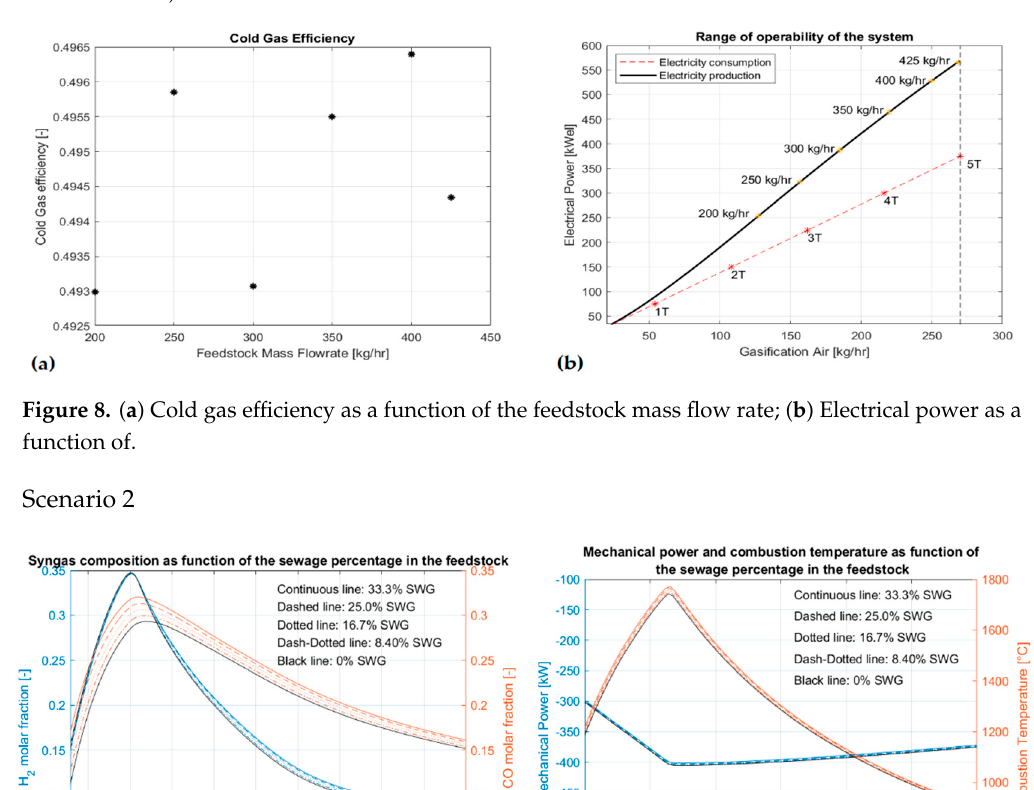
Figure 10. ( a ) Syngas and feedstock lower heating value (LHV) as a function of sewage fraction; ( b ) cold gas efficiency as a function of the sewage fraction. Figure 11. ( a ) Sorbent consumption as a function of sewage fraction; ( b ) mechanical power and heat recovered as a function of sewage fraction.